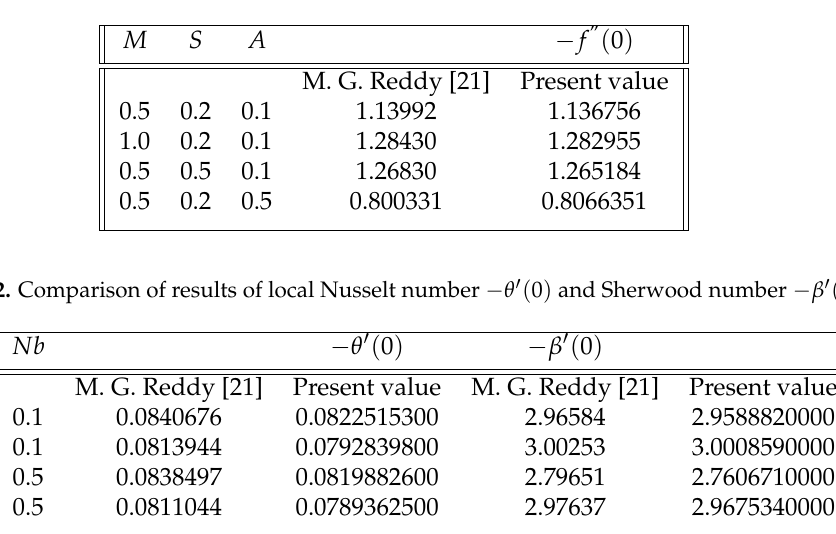
Table 1. Comparison of results of skin friction coefficient − f ” ( 0 ) for various values of M , S and A